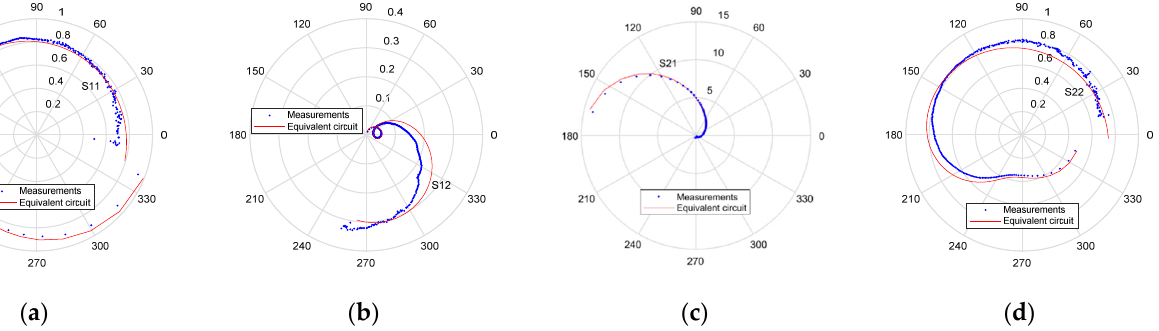
Figure 9. Measured (blue symbols) and equivalent-circuit simulated (red lines) behavior of ( a ) S 11 , ( b ) S 12 , ( c ) S 21 , and ( d ) S 22 with the frequency range spanning from 200 MHz to 65 GHz for the DUT at V DS = 30 V, V GS = − 3.1 V, and T a = 200 °C.